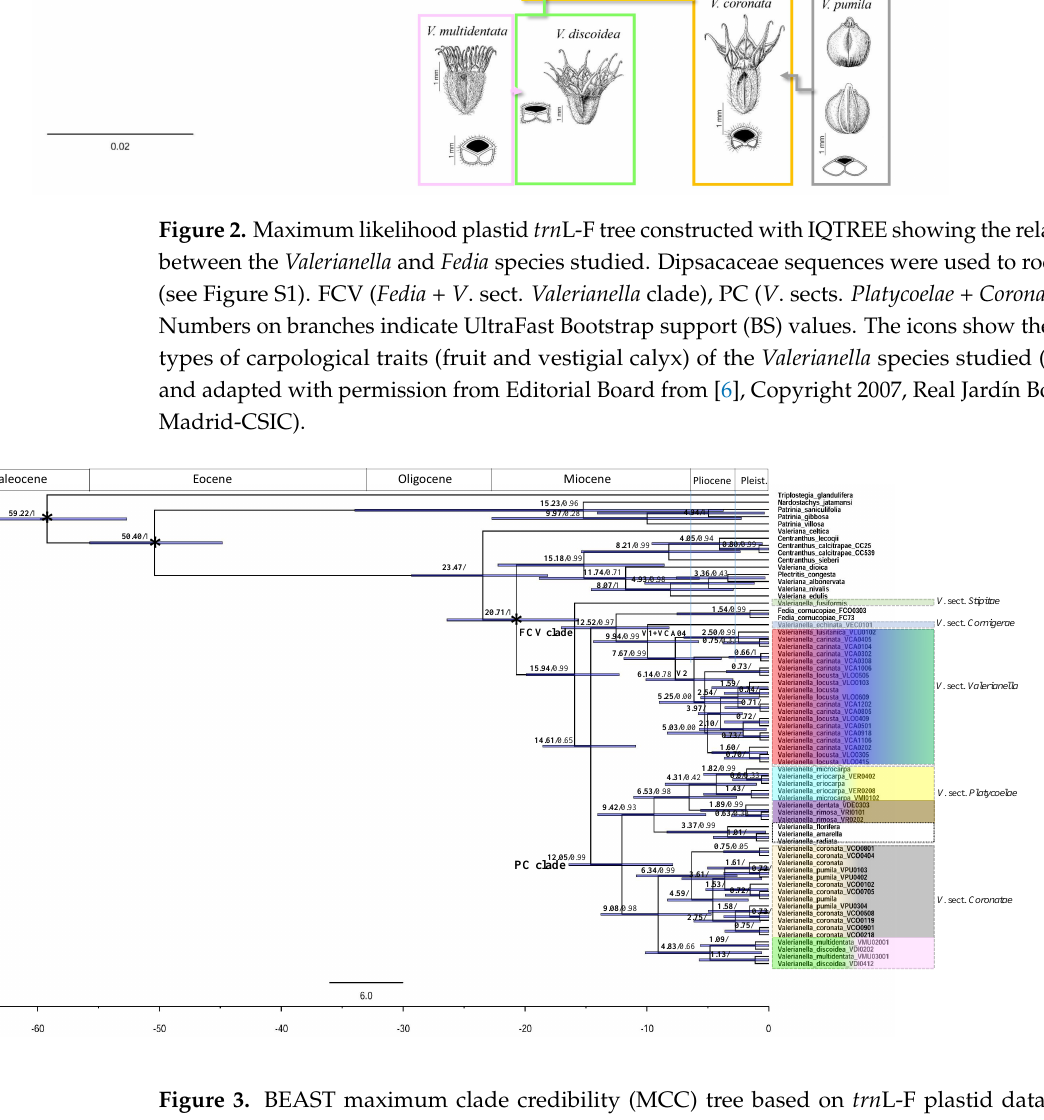
Figure 3. BEAST maximum clade credibility (MCC) tree based on trn L-F plastid data showing the estimated mean nodal ages of the Valerianella and Fedia cornucopiae lineages studied. Asterisk represents the imposed calibrations (see text). Numbers above the branches indicate the estimated ages (in bold) and the Bayesian posterior probability support (PPS) values (plain text). Bars represent 95% highest posterior density (HDP) intervals. Main clades: FCV ( Fedia + sect. Valerianella ), PC (sect. Platycoelae + sect. Coronatae